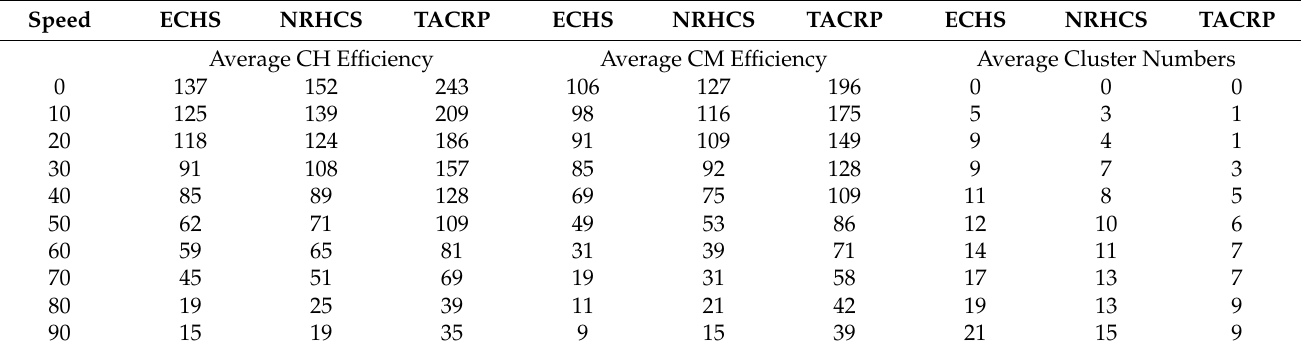
Table 5. Overall Performance Value Analysis, according to the speed of the vehicles.